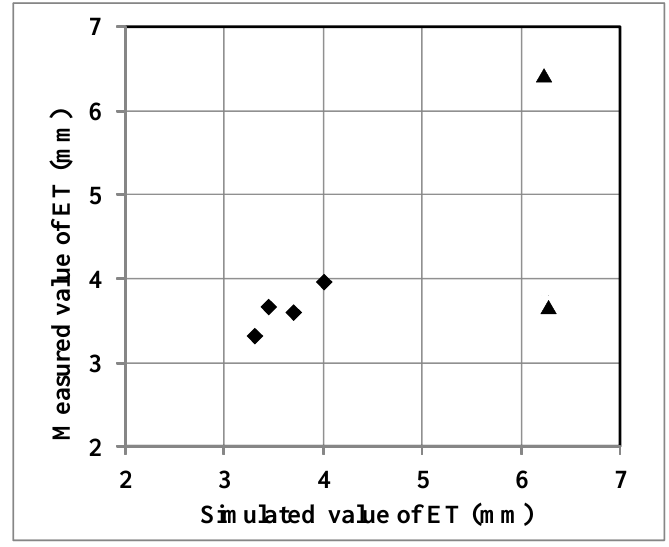
Figure 6. Comparison of simulated and measured ET at KoFlux Sites. (Black squares are ET values simulated by GF4, while black triangles are ET values simulated by MODIS).